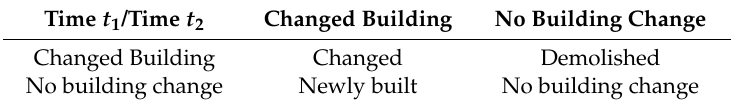
Figure 10. Step of determining the change type of a building using spatial correspondence analysis. Table 1. Change type determination with the guidance of a priori knowledge.